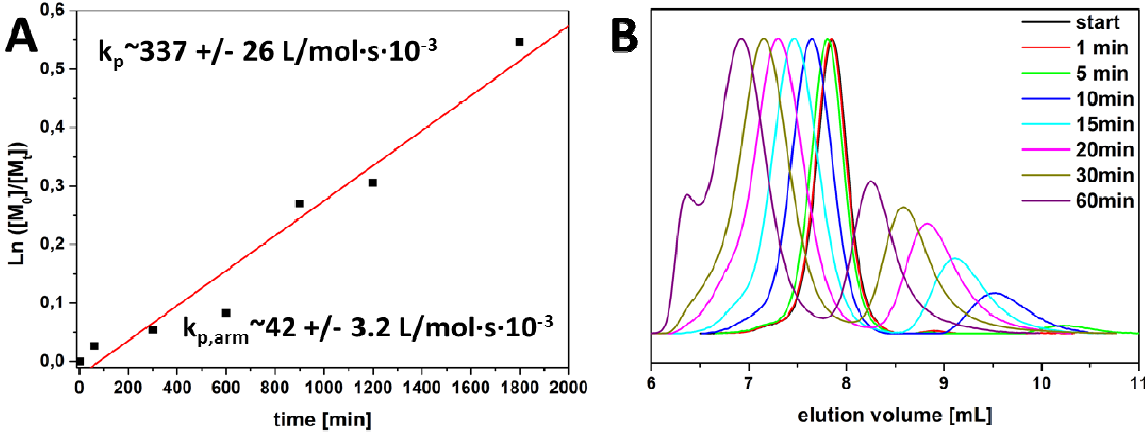
-Ts] as the initiator at 140 °C ( A ); 28 8 ) for the polymerization of EtOx ( B ). 3